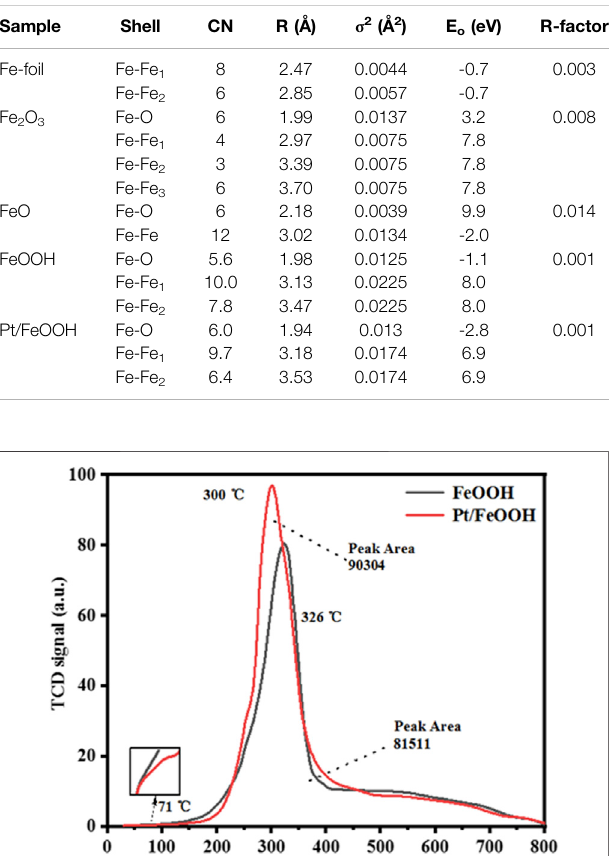
TABLE 3 | Fitted EXAFS results of Pt/FeOOH catalysts.